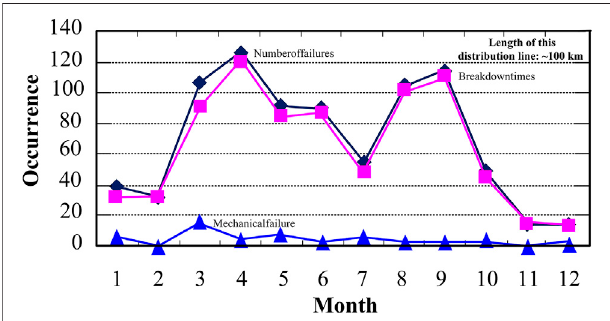
FIGURE 1 | Statistical chart of annual lightning arrester failure times and main